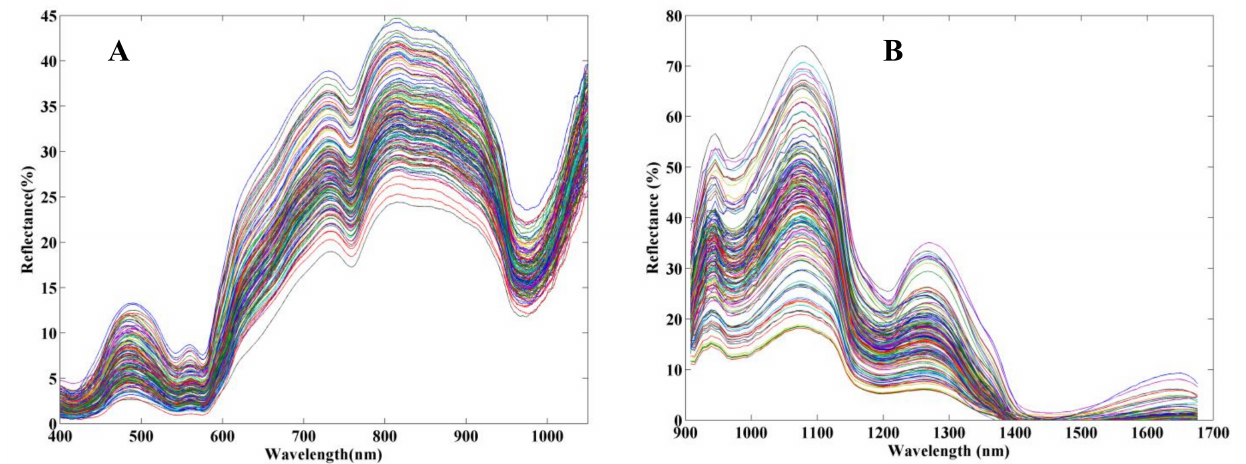
Figure 1. The raw reflective spectra of the samples in two regions. ( A ) refers to Vis/NIR spectroscopy ranging from 400 to 1050 nm of the sample, ( B ) refers to the spectrum of samples which ranged from 950 to 1700 nm, spectral curves of different color come from different